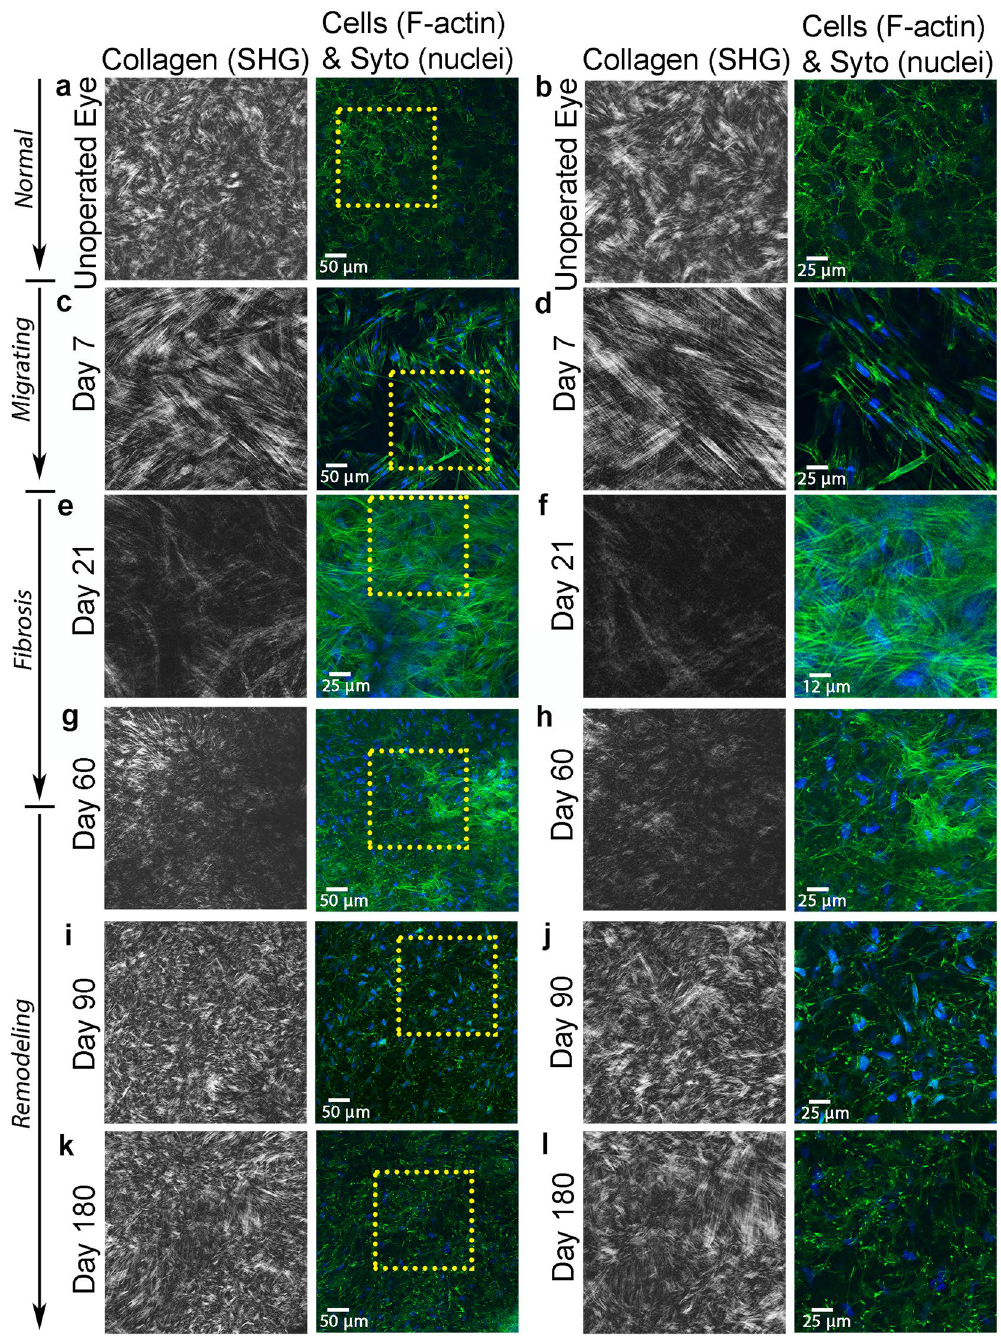
Figure 4. SHG forward scatter (collagen) and multiphoton fluorescent (F-actin-green, and nuclei-blue) en face images. Images are from: ( a , b ) unoperated cornea, and ( c , d ) 7 days, ( e , f ) 21 days, ( g , h ) 60 days, ( i , j ) 90 days, and ( k , l ) 180 days after PRK. Images a, b were taken 20 µ m posterior to the basal lamina, and c, d were collected 24 µ m posterior to the photoablation site in the migrating region. Images e-l were collected from the fibrosis / remodeling region on top of the photoablated surface. Images ( b , d , f , h , j , l ) are 2x zoomed-in (yellow box) images from ( a , c , e , g , i , k ),